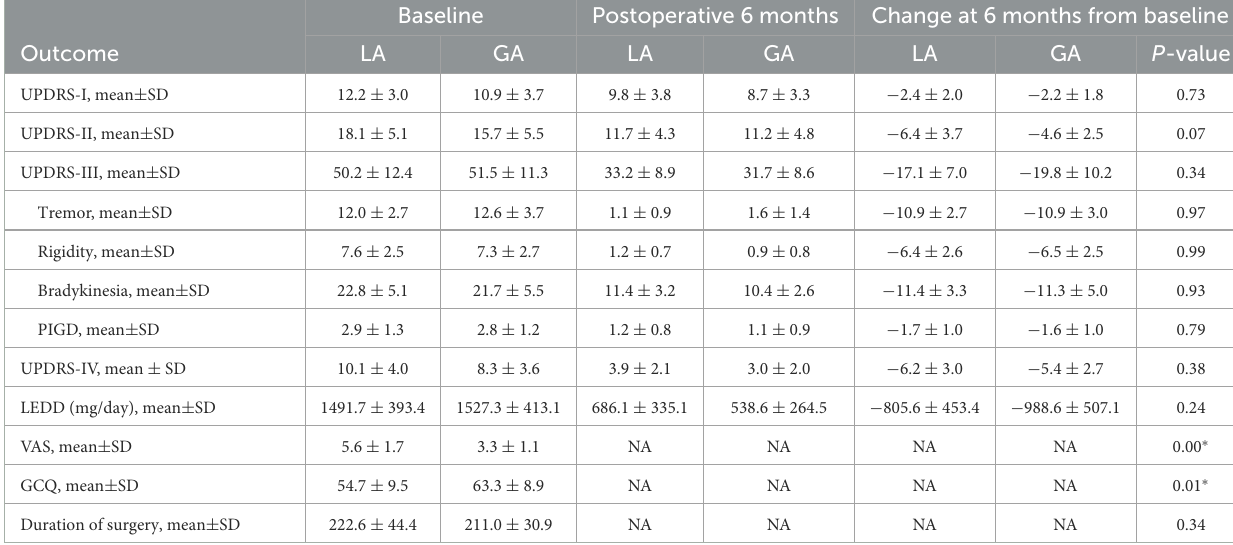
TABLE 4 Clinical outcome of MER guided STN-DBS